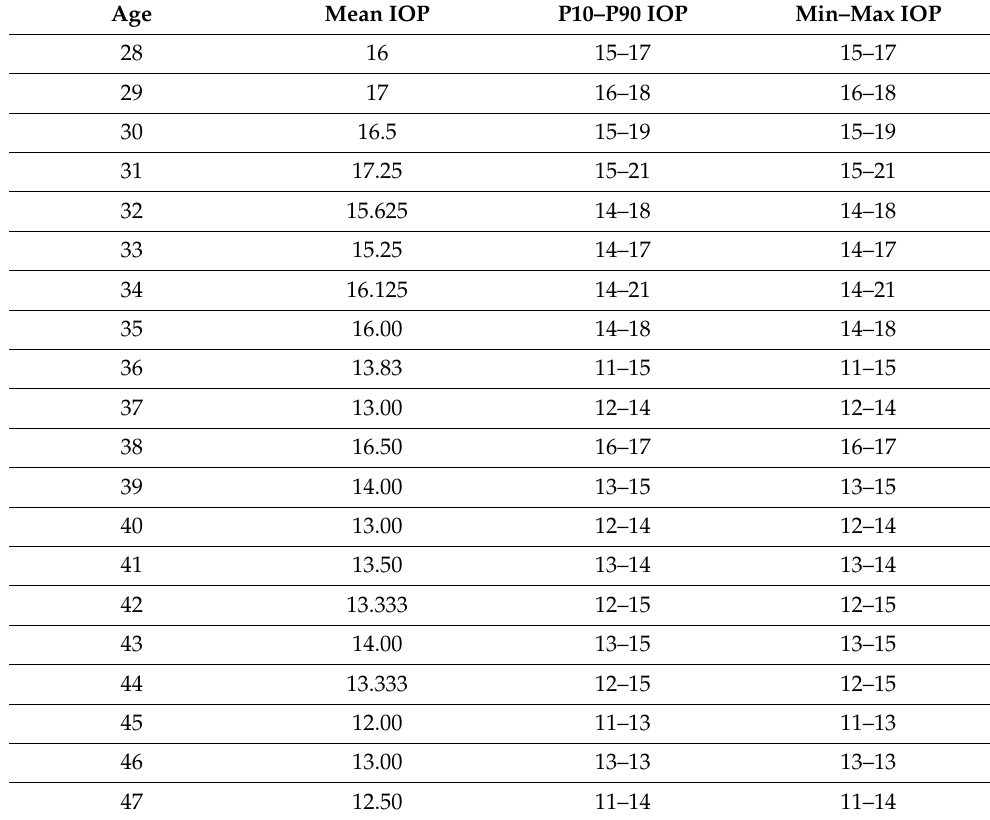
IOP—intraocular